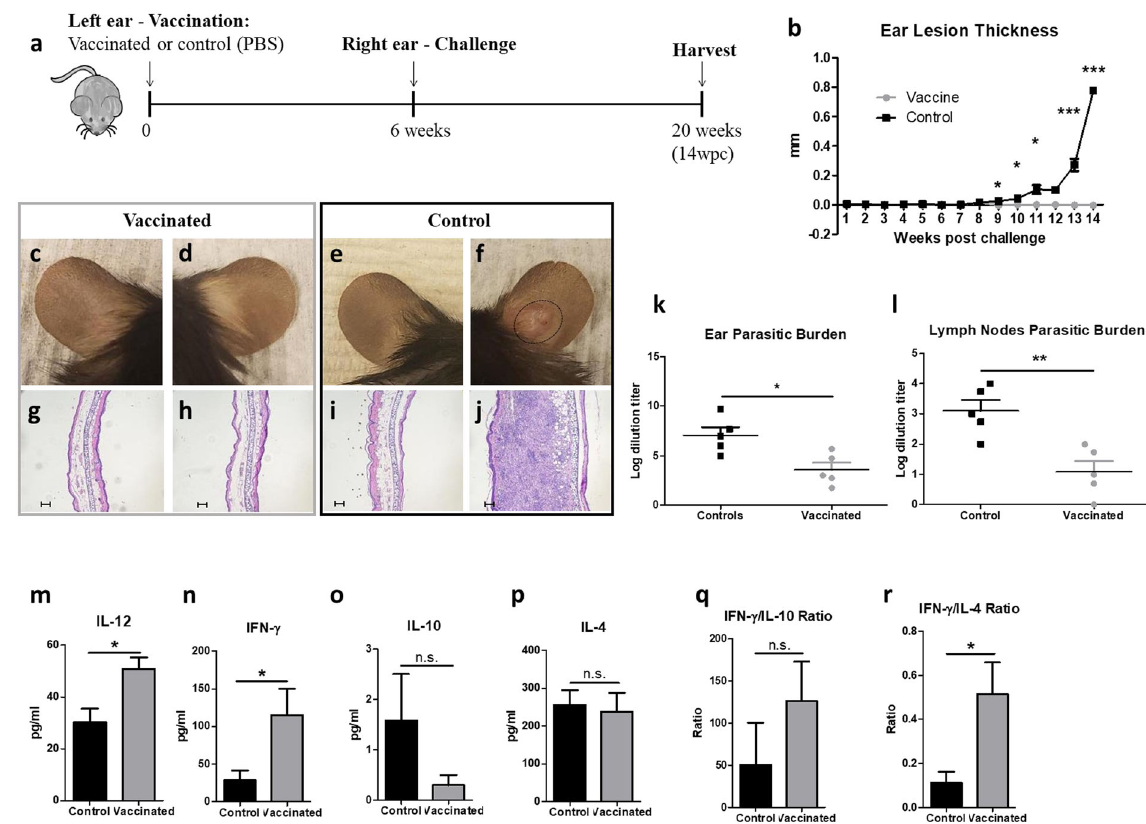
Fig. 8 LmexCen − / − immunization mediates protection against challenge with Lmex WT in C57BL/6. a Schematic of the vaccination study design for C57BL/6 mice. b Ear lesion thickness of vaccinated and control mice measured for 14 wpc. c – f Representative vaccinated ear ( c ), challenged ear of vaccinated mouse ( d ), PBS-inoculated ear of control mouse ( e ), and challenged ear of control mouse ( f ) at 14 wpc. g – j H&E staining of cross-section of representative vaccinated ear ( g ), challenged ear of vaccinated mouse ( h ), PBS-inoculated ear of control mouse ( i ), and challenged ear of control mouse ( j ) at 14 wpc. Scale bar for g – j : 100,000 μ m. k , l Parasitic burdens in the ear ( k ) and draining lymph nodes ( l ) at 14 wpc. m – p Cytokine levels of IL-12 ( m ) IFN- γ ( n ), IL-10 ( o ), and IL-4 ( p ) in the lymph nodes of vaccinated and control mice stimulated with L. mexicana antigen at 14 wpc. q , r Ratio between IFN- γ /IL-10 ( q ) and IFN- γ /IL-4 ( r ) levels in the lymph nodes of vaccinated and control mice at 14 wpc. Data show one representative experiment out of two independent experiments and show mean ± SEM, N = 5 for each group at each time point. Unpaired two-tailed Student ’ s t -test was performed to compare statistical signi fi cance at each time point. A P -value < 0.05 was considered signi fi cant. In all panels * represents P ≤ 0.05, ** represents P ≤ 0.01, and *** represents P ≤